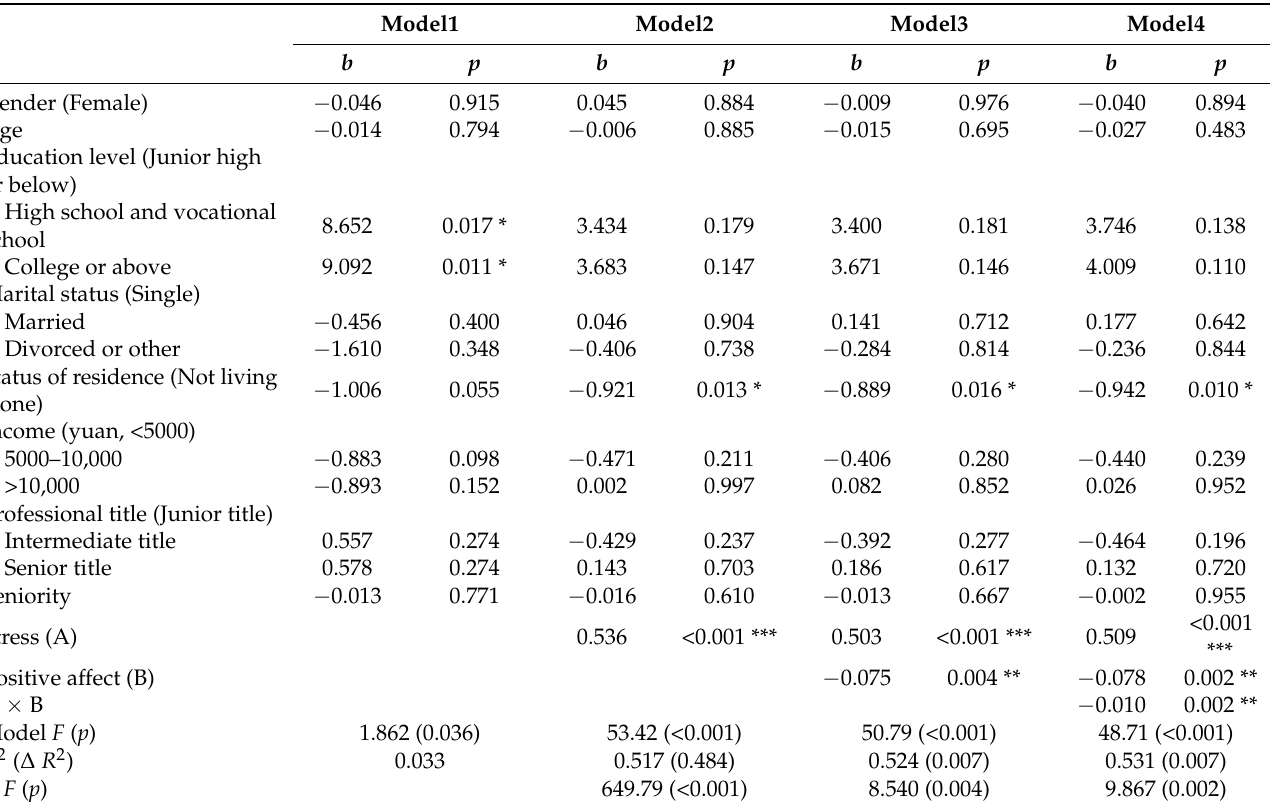
Table 3. Moderating effect of positive affect on the relationship between stress and depression in the total group.